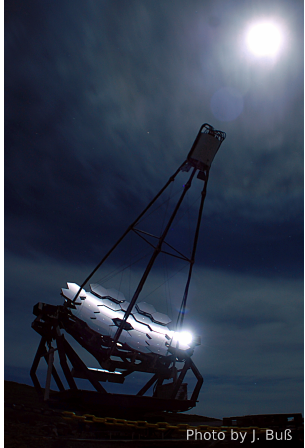
Figure 1. FACT—Observation during strong moon